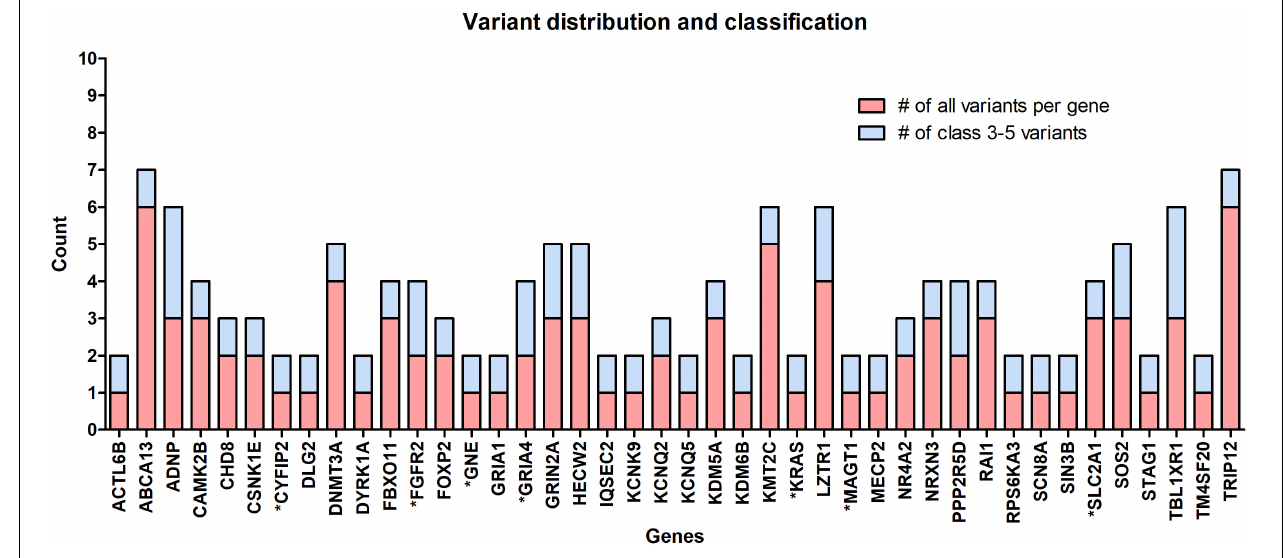
FIGURE 2 | The occurrence of all rare variants per gene (red) and the number of those classified as clinically significant variants (blue). In 18 out of 42 identified genes, 1 variant per gene occurred, the so-called “single event” variant. Genes marked with an asterisk ( ∗ ) belong to the group of NDD-associated genes.